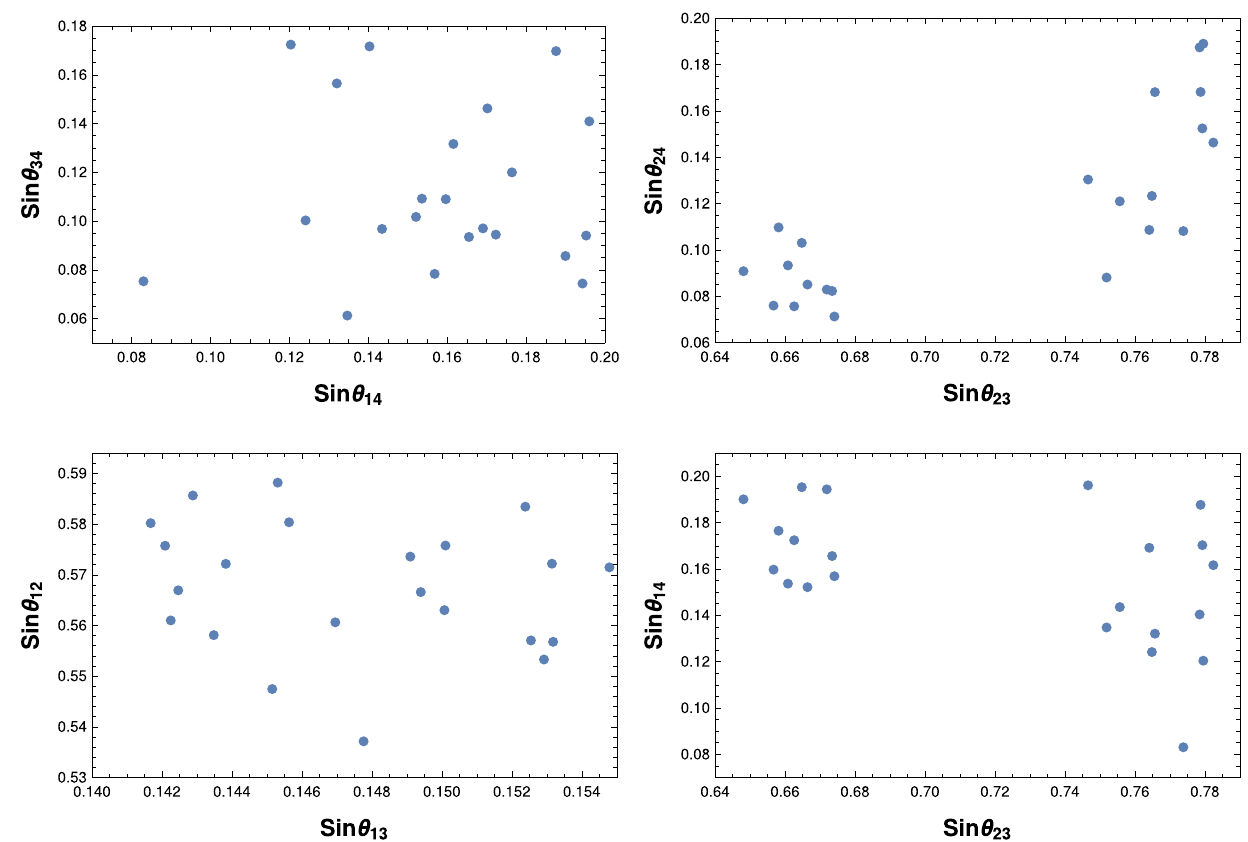
Fig. 3 Neutrino oscillation parameters in active-sterile sector for case (iv) from μ – τ symmetric category for NH